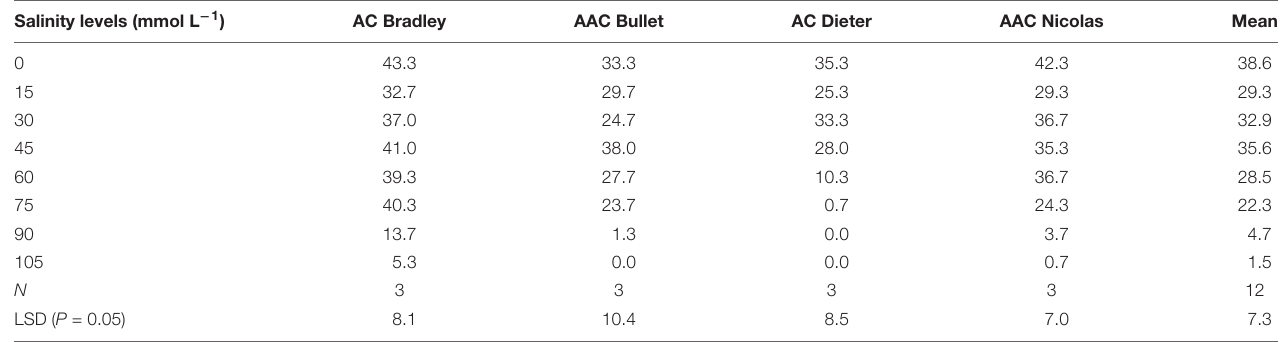
TABLE 2 | Number of germinated seeds (out of 50) for four oat genotypes under different concentrations of salt. Salinity levels (mmol L − 1 )